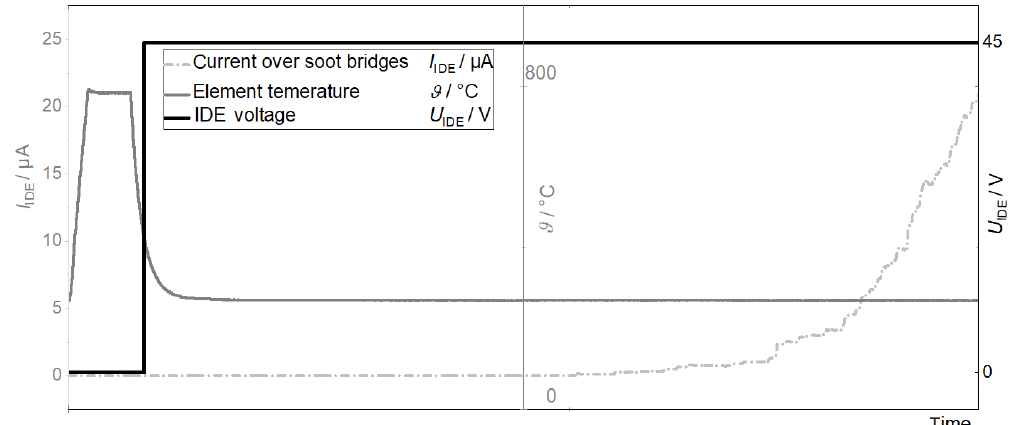
Figure 2. From left to right: regeneration phase at ϑ ≈ 780 ◦ C and cooling down to exhaust temperature, with a transition to the measurement phase. During the measurement phase the current is zero as long as no soot bridge is formed (downtime) and rises exponentially due to the formation of many parallel conductive paths. After a predefined threshold is reached, the sensor regenerates itself and a new cycle